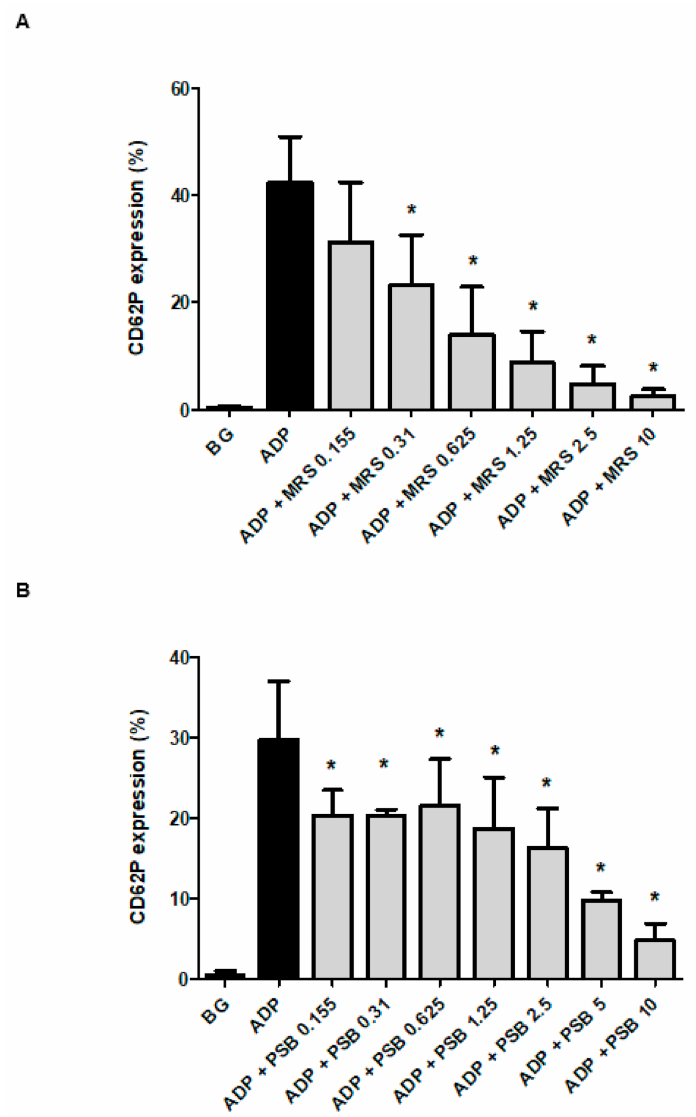
Figure 1. E ff ects of MRS2500 (MRS) ( A ) and PSB0739 (PSB) ( B ), (0.155–10 µ mol · L − 1 ) on the magnitude of expression of CD62P on platelets activated with ADP (100 µ mol · L − 1 ). The results are expressed as the mean% activated platelets ± SDs. * p < 0.05– p < 0.001 for comparison with the drug-free control system. BG = unstimulated platelets ( n = 4–6 individual donors with 4–8 experiments in each series). The inhibitory e ff ects of MRS2500 at concentrations of 0.155 and 0.31 µ mol · L